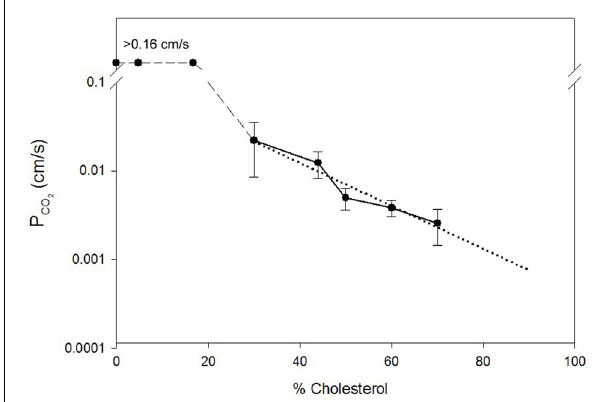
FIGURE 2 | Dependence of the CO 2 permeability of phospholipid vesicles on their cholesterol content. The latter is given on the x-axis in mol% per total membrane lipid. Vesicle phospholipid composition was was determined by the phospatidylcholine:phosphatidylserine = 8:2. P CO 2 mass spectrometric 18 O exchange technique. Dotted line is the linear regression line for all data points between 30 and 70% cholesterol. P CO 2 values between 0 and 17% cholesterol were above the upper limit of detectability of the method of 0.16cm/s. Figure reproduced from Itel et al. (2012), with